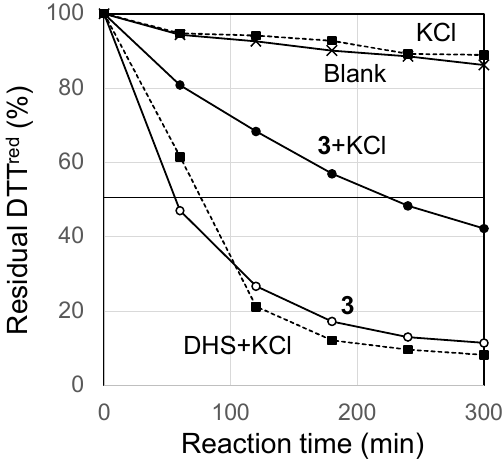
Figure 7. Percentages of residual DTT red as a function of the reaction time in the oxidation of DTT red with H 2 O 2 in the presence of DHS-crown-6 ( 3 ) in CD 3 OD. Reaction conditions: [DTT red ] 0 = [H 2 O 2 ] 0 = 0.14 mol/L and [ 3 ] = 0.014 mol/L at 25 °C in the absence or presence of KCl (0.014 mol/L).